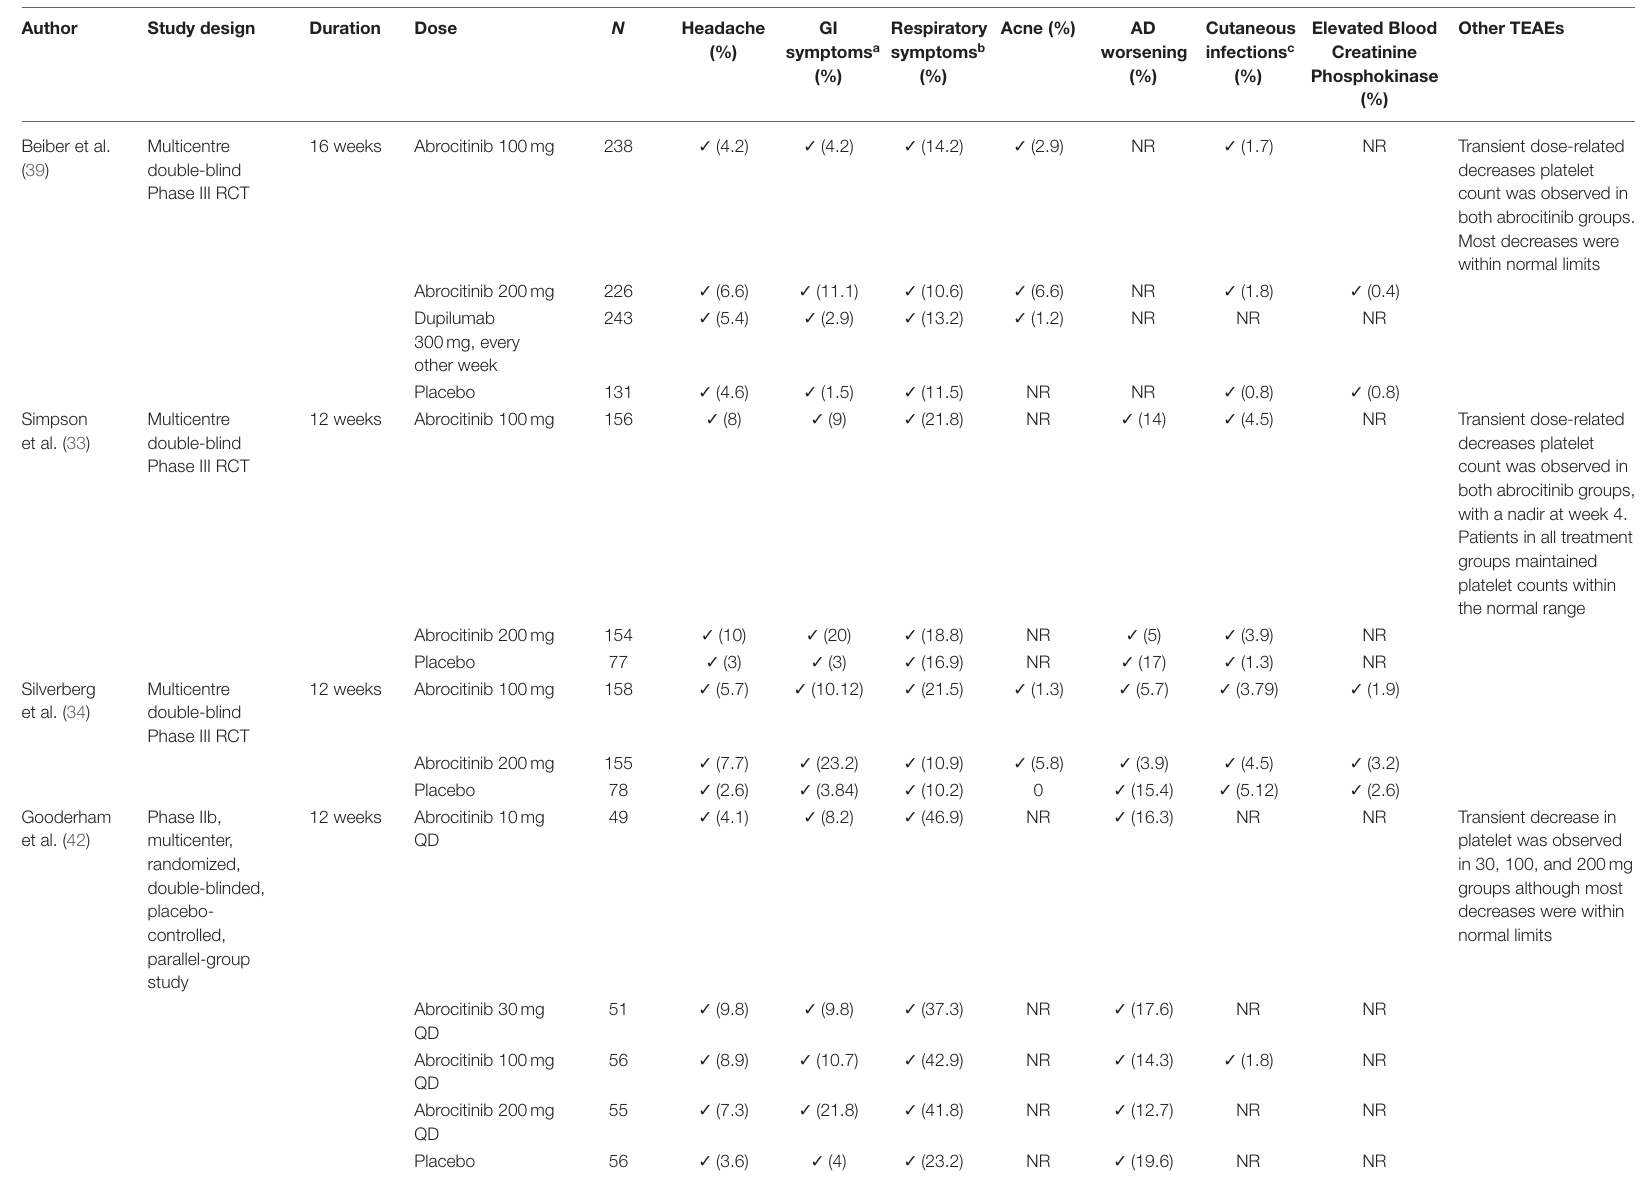
TABLE 2 | Summary of common TEAEs in published oral JAK inhibitor